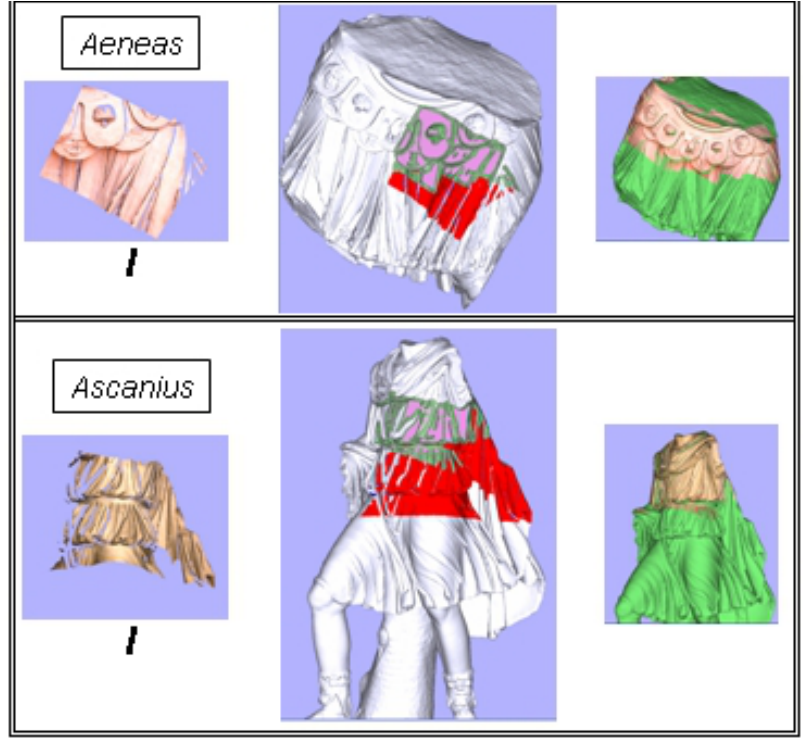
Figure 9. Left: Images to be merged ( I ) from the Aeneas and Ascanius’ scans. Centre: Filter windows superimposed onto the models, the seam patches are shaded in grey and the points that fall into the Gaussian mask in green. The pink zones represent redundant colour. Right: the final result after the final smoothing